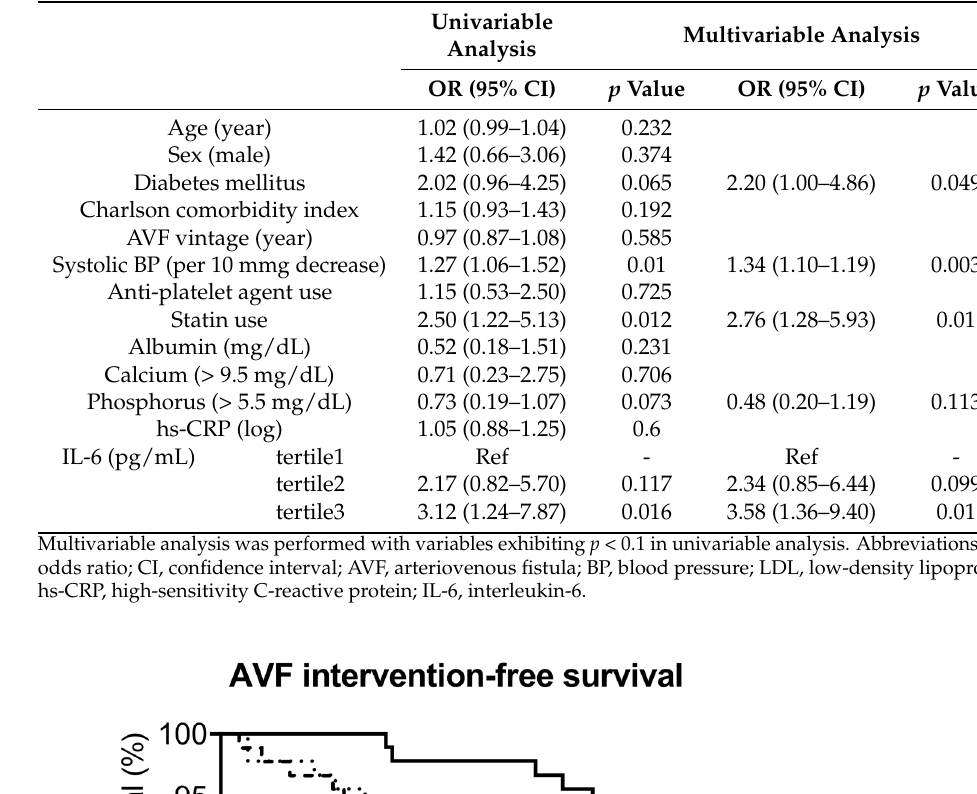
Table 2. Multivariable analysis for the prediction of arteriovenous fistula dysfunction.